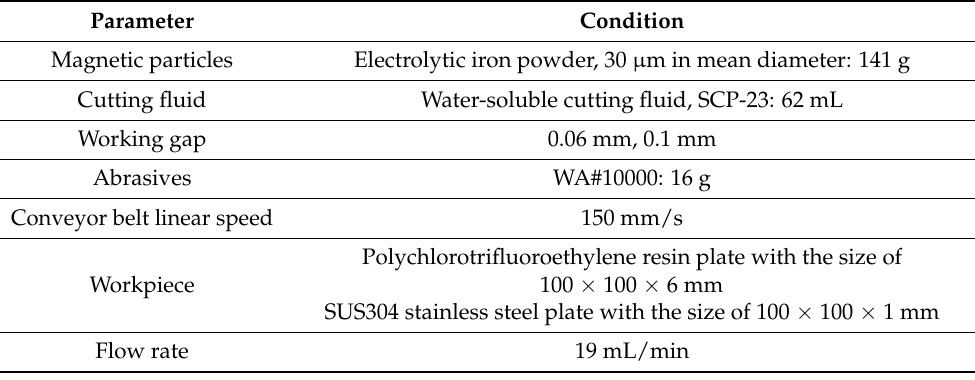
Table 1. Measuring conditions. Figure 8. Schematic diagram of force measurement system.